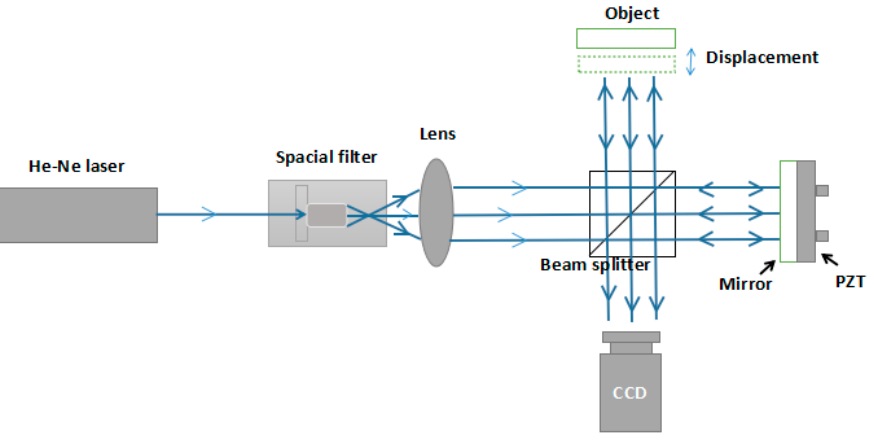
Figure 9. The schematic drawing of the measurement system. The 100 fringe patterns from the fringe projection experiment and 100 interferograms were selected to evaluate the trained network, and the remainder was used to training the model. During the training, the wrapped phase dataset as the output of the neural network was calculated by the four-step phase-shifting